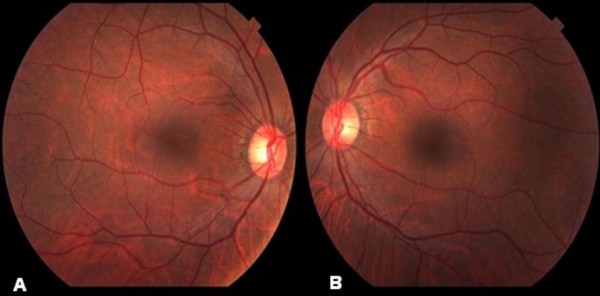
Eye fundus photograph showing the absence of diabetic retinopathy. A - Right eye B - Left eye.